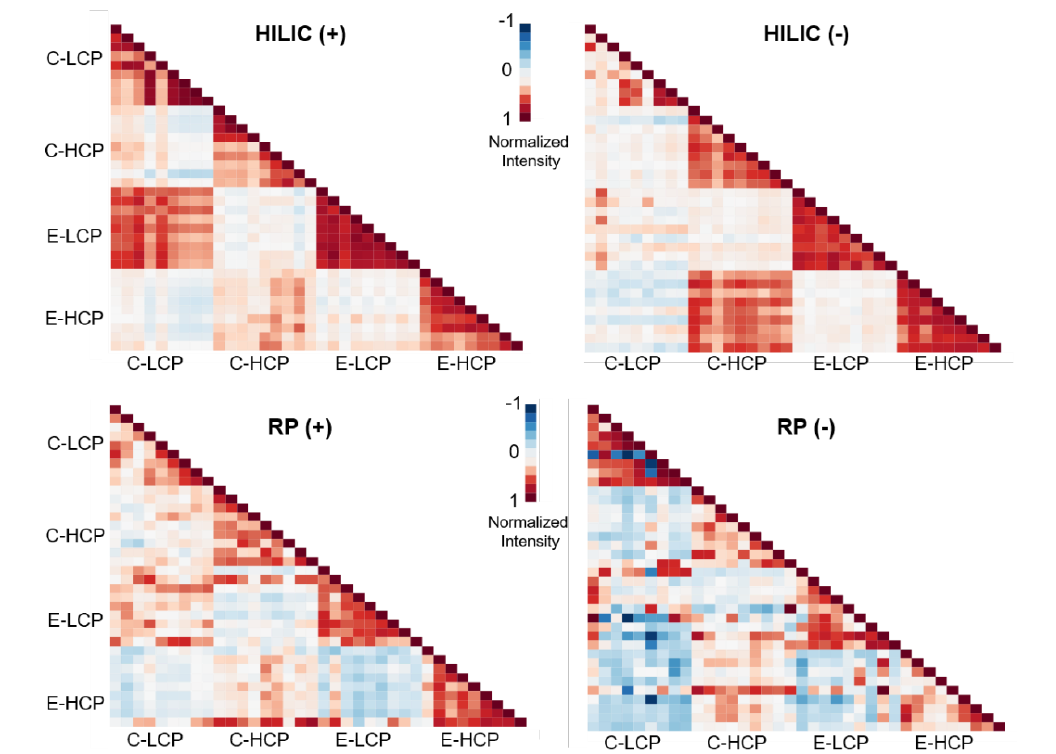
Figure 2. Correlation plots for each LC/MS condition of the log 2 peak areas (abundance) for the 36 samples analyzed after normalization procedures. C = Carex aquatilis , E = Eriophorum angustfolium , A = Site A or LCP, and B = Site B or HCP.